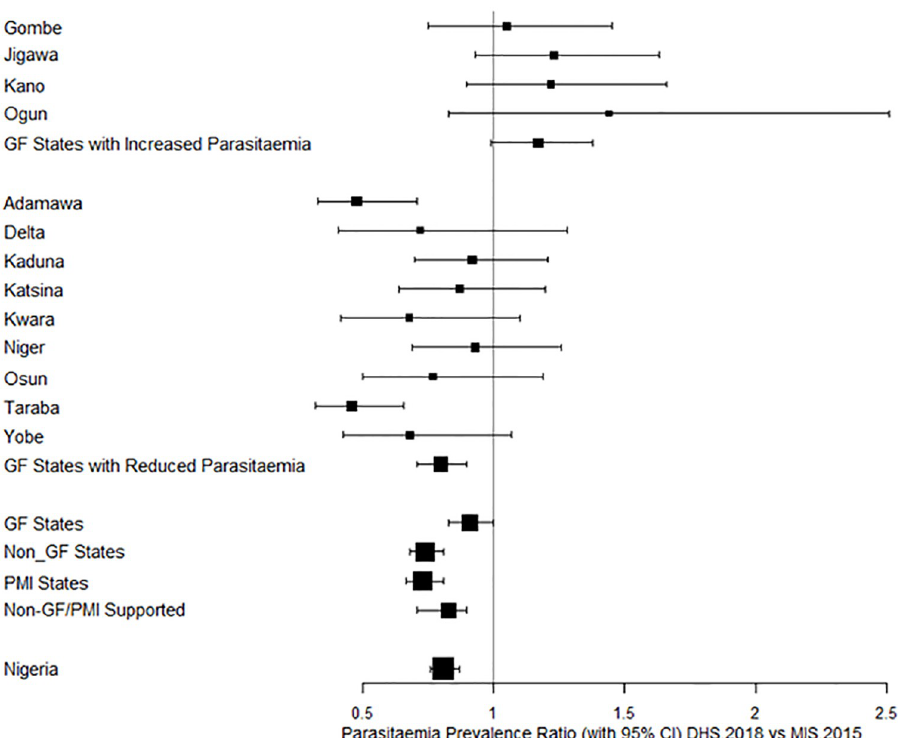
Fig 3. Forest Plot of Prevalence Ratio with 95% CI in 2018 vs